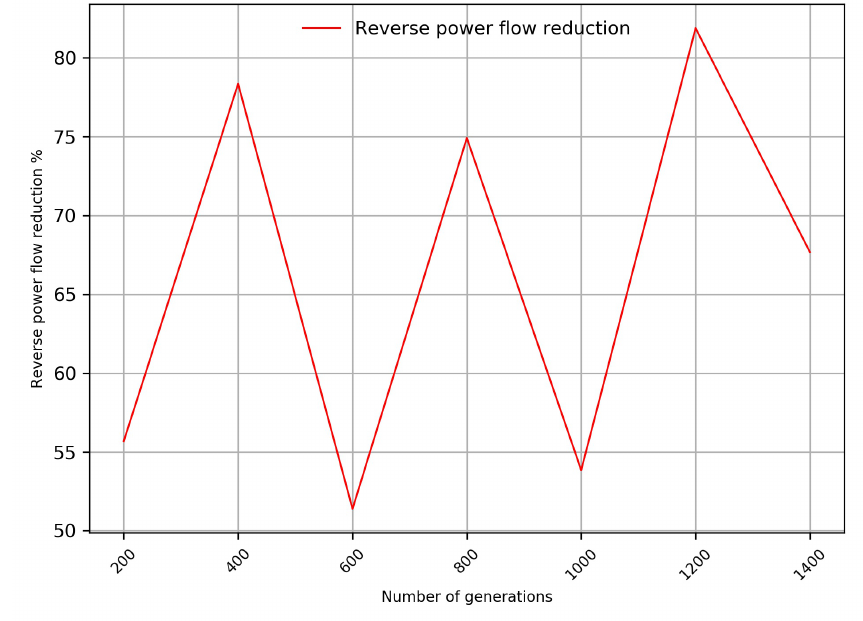
Figure 7. RPF % evolution according to the number of